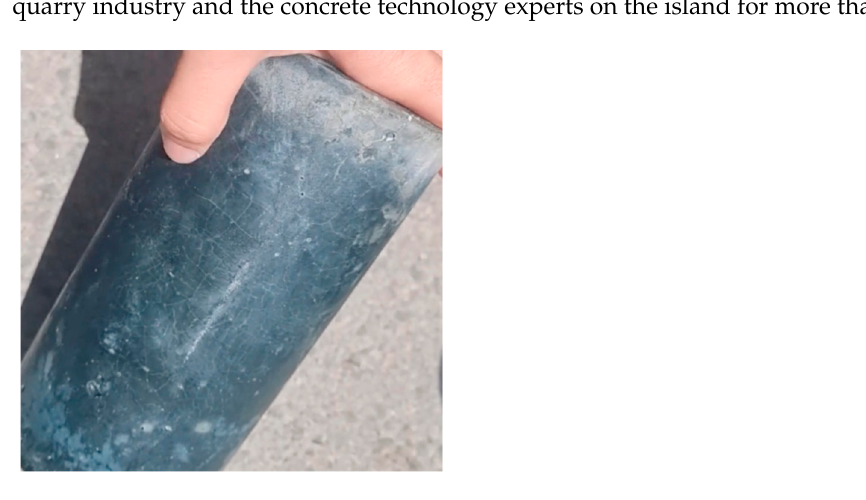
9 of 16 Figure 5. Modulus of Elasticity, E (GPa) vs. Compressive Strength (MPa) at 28 ‐ days maturity. In accordance with the 28 ‐ day compressive strengths trend (Figure 4), and as ex ‐ pected, the material E values increased with increasing GGBS content. Considering each mixture compressive strength average at 28 days, the E values obtained are slightly lower than the expected E values of concrete mixtures with similar compressive strengths. Spe ‐ cifically, the 70%DM ‐ 30%GGBS mix had a 69.38 MPa average 28 ‐ day compressive